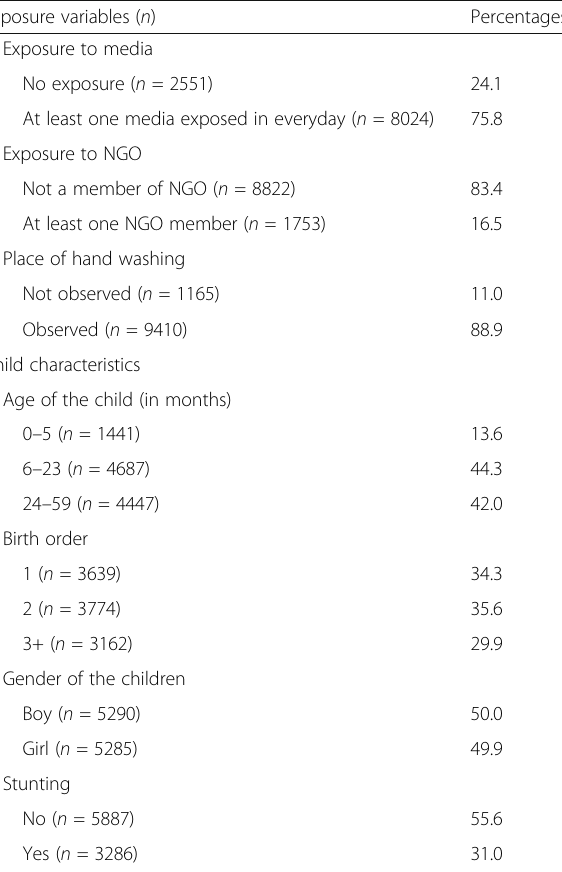
Table 1 Descriptive statistics of participant ’ s residential factors, mother ’ s characteristics, and child characteristics